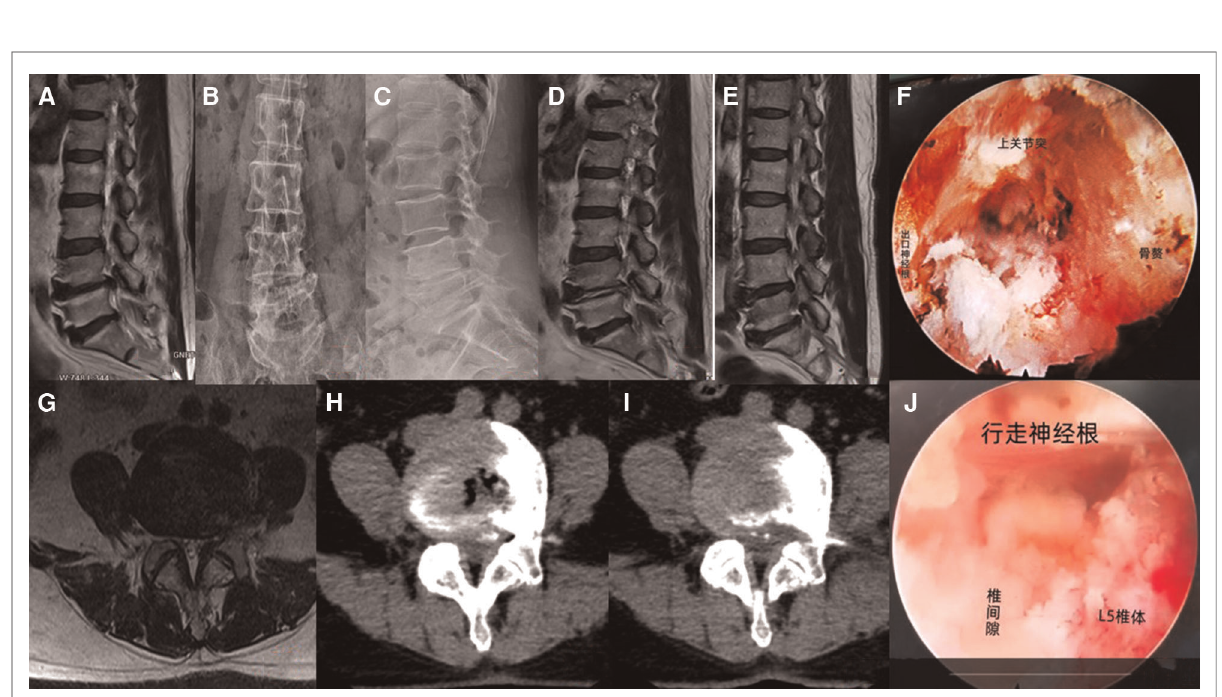
FIGURE 6 ( A ) preoperative MRI in sagittal position; ( B,C ) preoperative x-ray radiograph in lumbar dynamic position showing no lumbar instability or spondylolysis, the left L4/5 space collapsed and osteophytes formed; ( D ) sagittal MRI 2 days after surgery; ( E ) sagittal MRI 6 years after surgery; ( F ) the situation under the endoscope when inserting the working channel; ( G ) preoperative MRI in coronal position; ( H ) preoperative CT in coronal position; ( I,K ) coronal CT 2 days after surgery; ( J ) suf fi cient decompression of the nerve root was seen under the